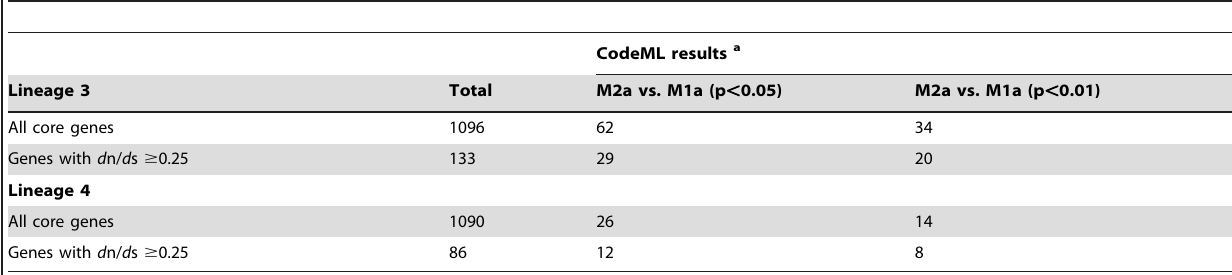
Table 2. Number of genes revealing significant positive selection in the CodeML analysis for lineage 3 and lineage